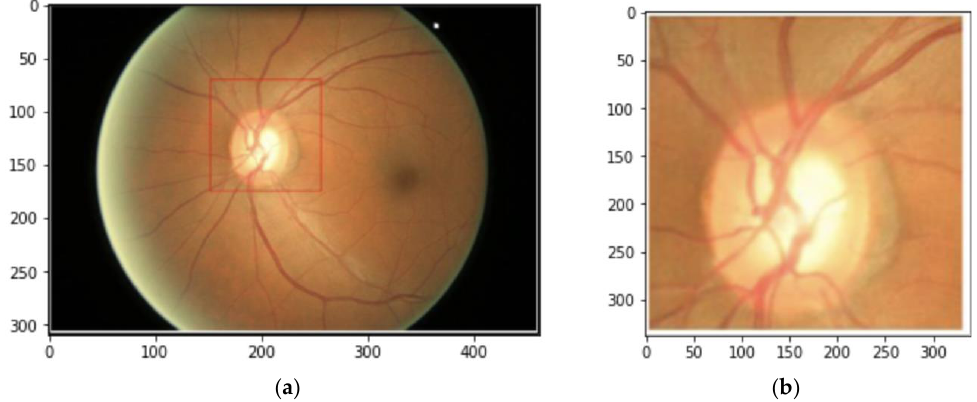
Figure 7. The illustration of ( a ) the RoI marked by a red rectangle with size 702 by 702 pixels and ( b ) the cropped RoI from the rectangle.